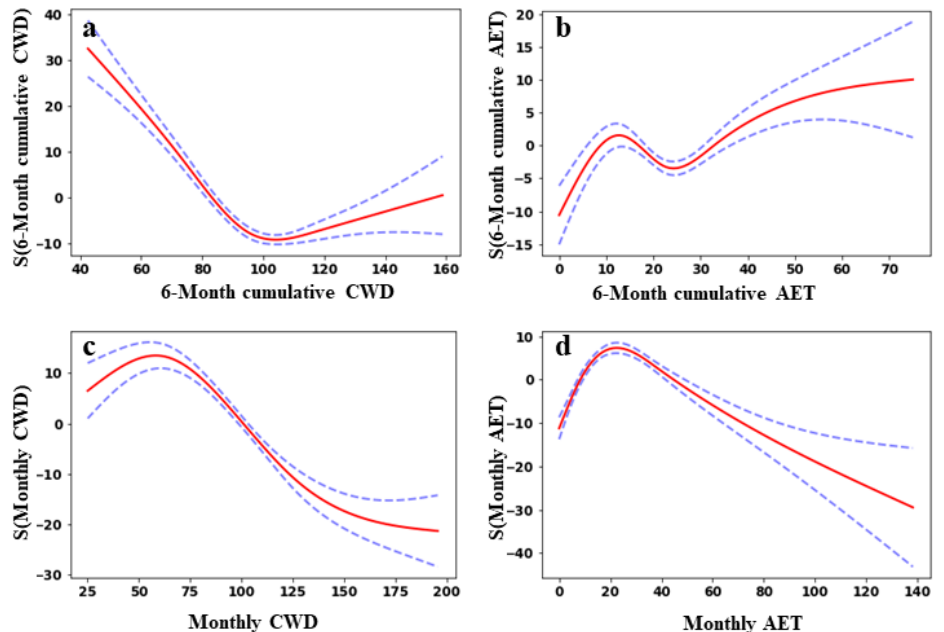
Figure A4. Smoothed coefficients of ( a ) cumulative precipitation over the prior six months, ( b ) monthly precipitation (2 month lag), ( c ) mean maximum temperature (2 month lag), and (d) mean monthly precipitation (2 month lag).